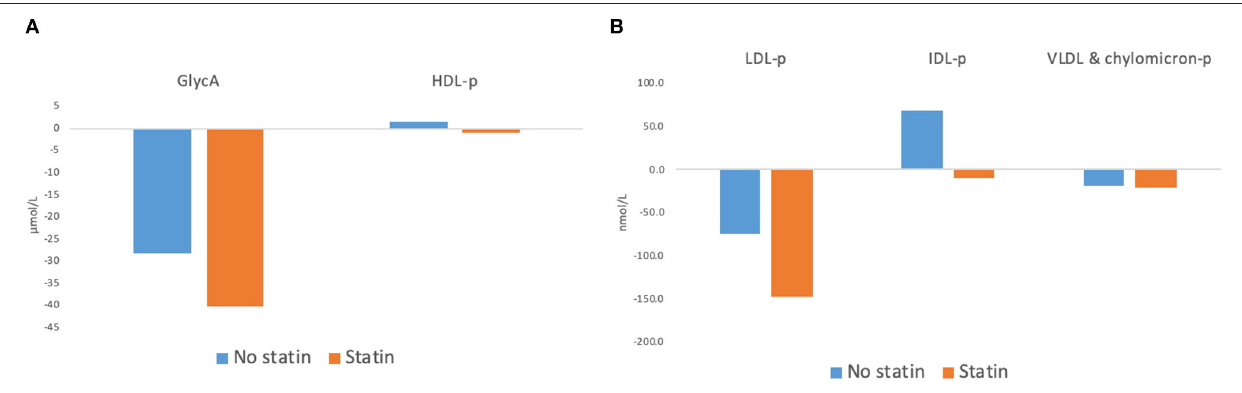
FIGURE 2 | Changes in (A) GlycA and HDL-particles and (B) LDL-particles, IDL-particles, and VLDL and chylomicron particles after 12 weeks of dietary intervention, with stratification by use of Statin Therapy. HDL-p, high density lipoprotein particles; LDL-p, low-density lipoprotein particles; IDL, intermediate-density lipoprotein particles; VLDL & chylomicron-p, very-low-density lipoprotein and chylomicron